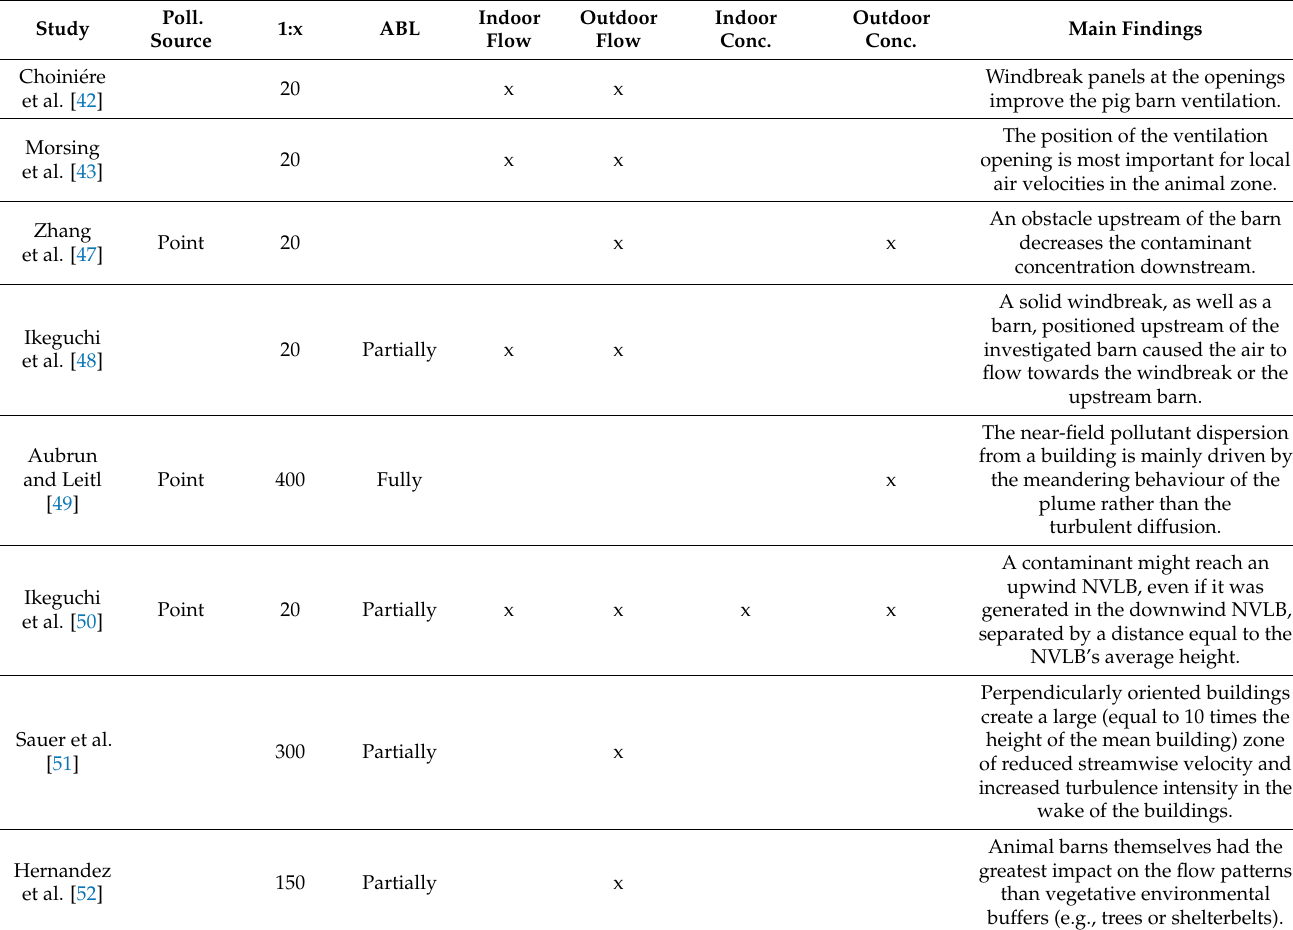
Table 3. Related wind tunnel studies on naturally ventilated livestock